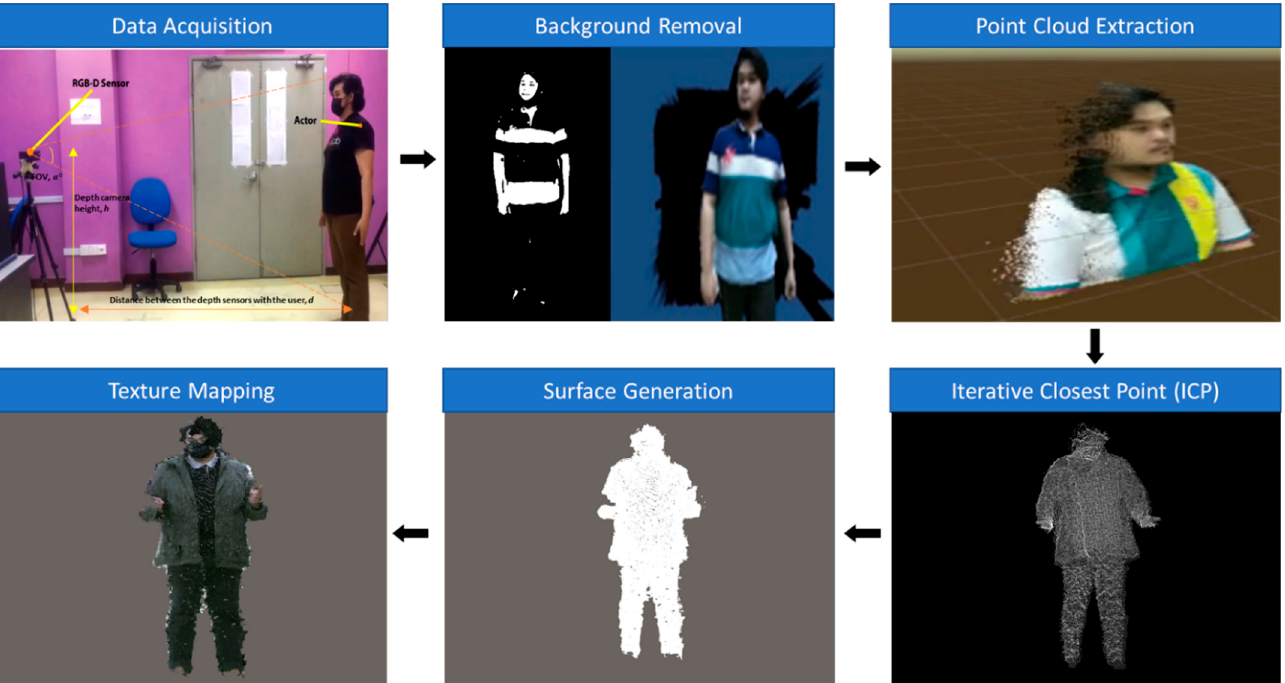
Figure 10. The real-time 3D reconstruction result from each stage. Table 1. The processing time records, the results in a comparison with previous work.